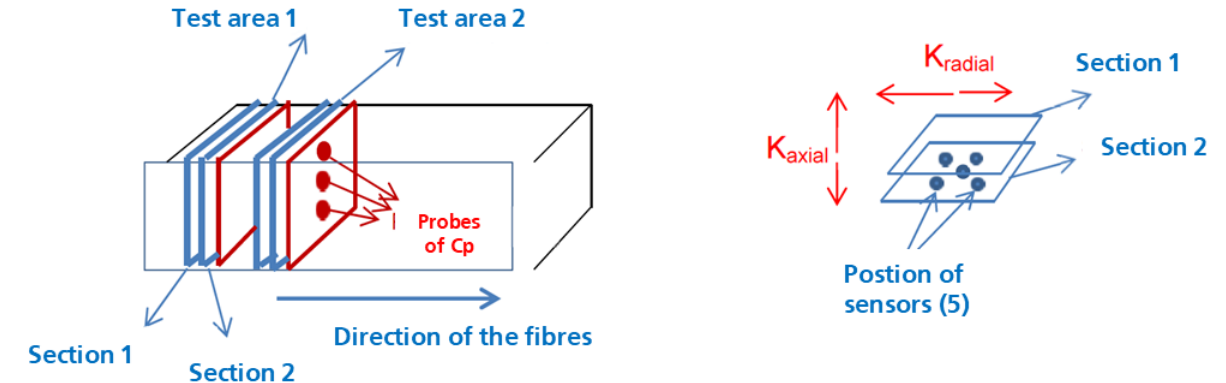
Figure 9. Effective thermal conductivity measurement.